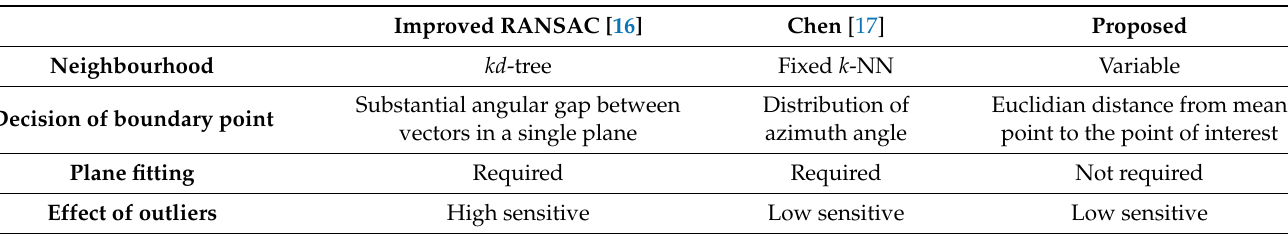
Figure 10. Extracted boundary points by ( a , d ) the Chen method [17], ( b , e ) the improved RANSAC method [16], and ( c , f ) the proposed method. Table 5. Comparison of different boundary point extraction